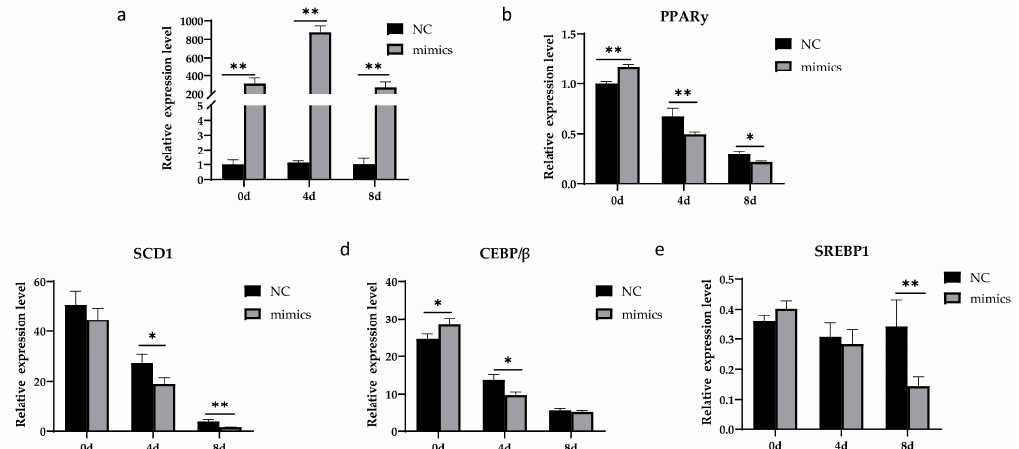
Figure 6. Overexpression of xeno-miR168b inhibited the expression of adipogenic marker genes in BMECs. Data are given as the mean ± SD for n = 3/group. * p < 0.05 or ** p < 0.01 were considered statistically significant. ( a ) Xeno-miR168b expression levels for 8 d after induction and ( b – e ) expres- sion of genes related to lipid metabolism in mtr-miR168b-transfected or NC-transfected BMECs. 3.5. Overexpression Xeno-miR168b Inhibited Lipid Droplet Formation and Reduced TG Content in BMECs